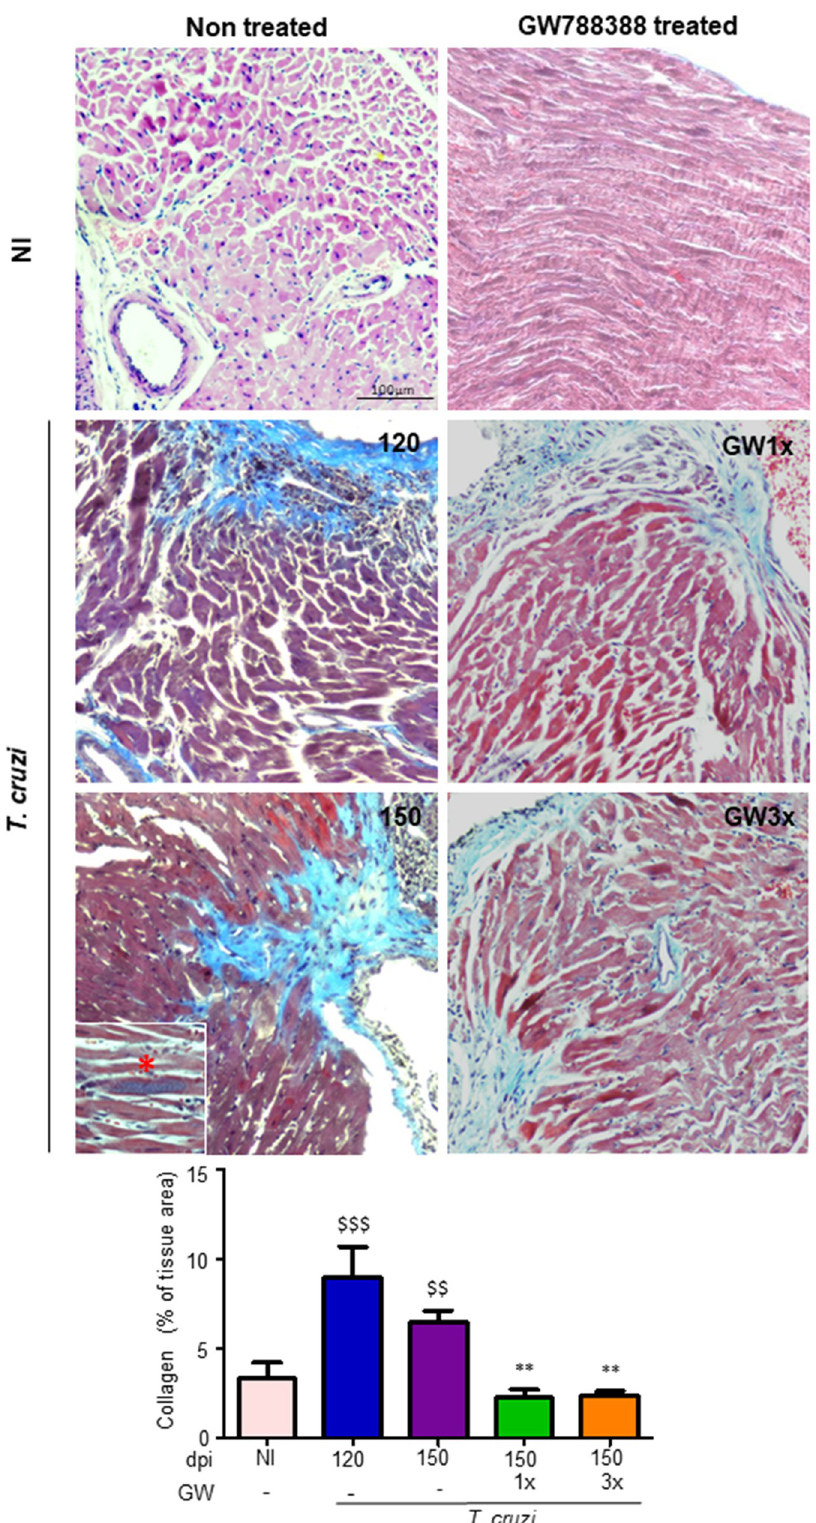
Fig 4. GW788388 treatment reverses heart fibrosis in mice chronically infected with T . cruzi . Mice were infected with the Colombian T . cruzi strain (10 2 parasites). Treatment with GW788388 started on 120 dpi until 150 dpi